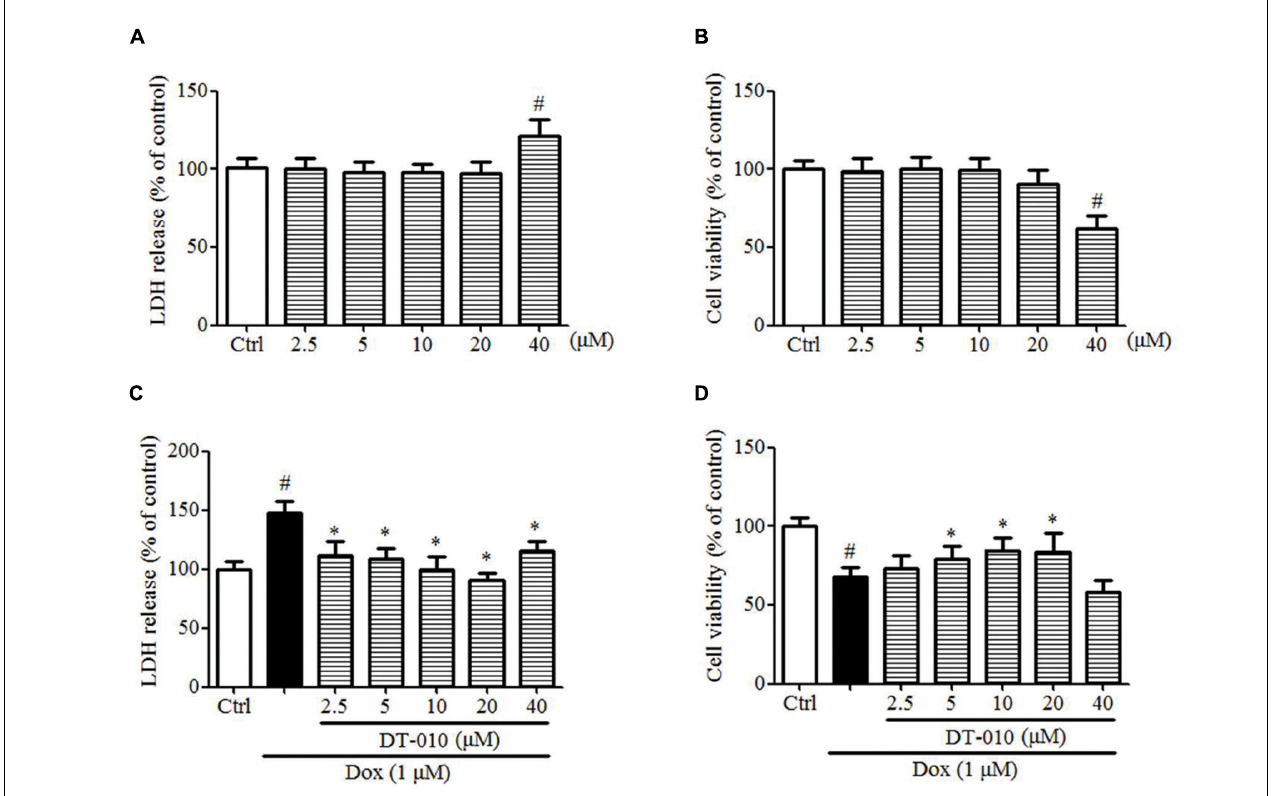
FIGURE 6 | DT-010 protected against Dox-induced toxicity in H9c2 cells. (A,B) H9c2 cells were treated with different concentrations of DT-010 for 24 h and the toxicity of DT-010 in H9c2 cells was measured by LDH assay and MTT assay, respectively. Dox treatment for 24 h significantly increased the cytotoxicity (C) and decreased cell viability (D) in H9c2 cells, which were reversed by DT-010 co-treatment. # P < 0.05 vs. Ctrl and ∗ P < 0.05 vs.